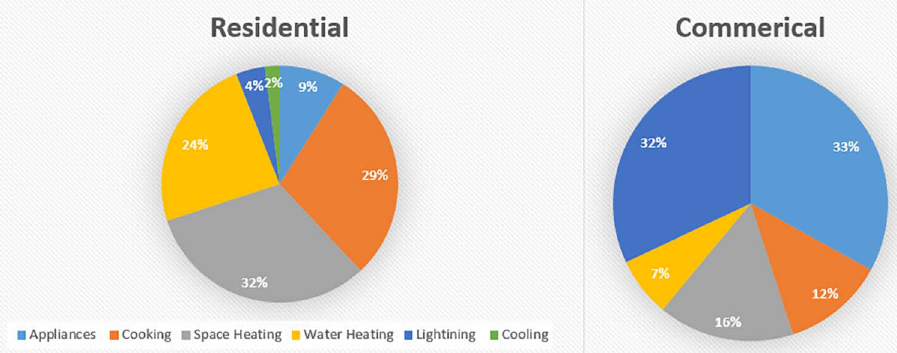
Figure 3. Energy Consumption Residential Vs Commercial Buildings (Adapted from IPCC